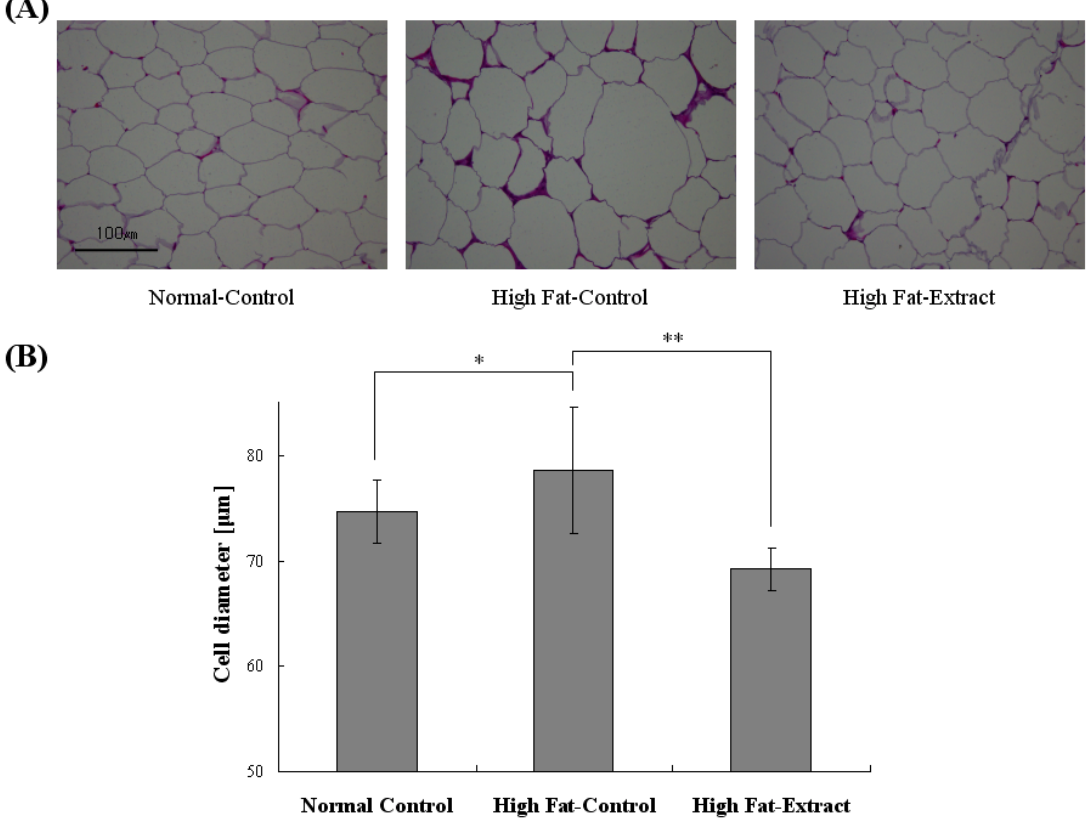
Figure 3. Effect of Buddleja officinalis Maximowicz extract on abdominal white adipose tissue (WAT) in high-fat diet mice ( A ) Histological analysis of WAT from control and high-fat diet and Buddleja officinalis Maximowicz treated high-fat model ( B ) Average fat cell size. Values are means ± (n = 9 per group) * p < 0.05 vs . normal diet; ** p < 0.001 high fat extract vs. high fat